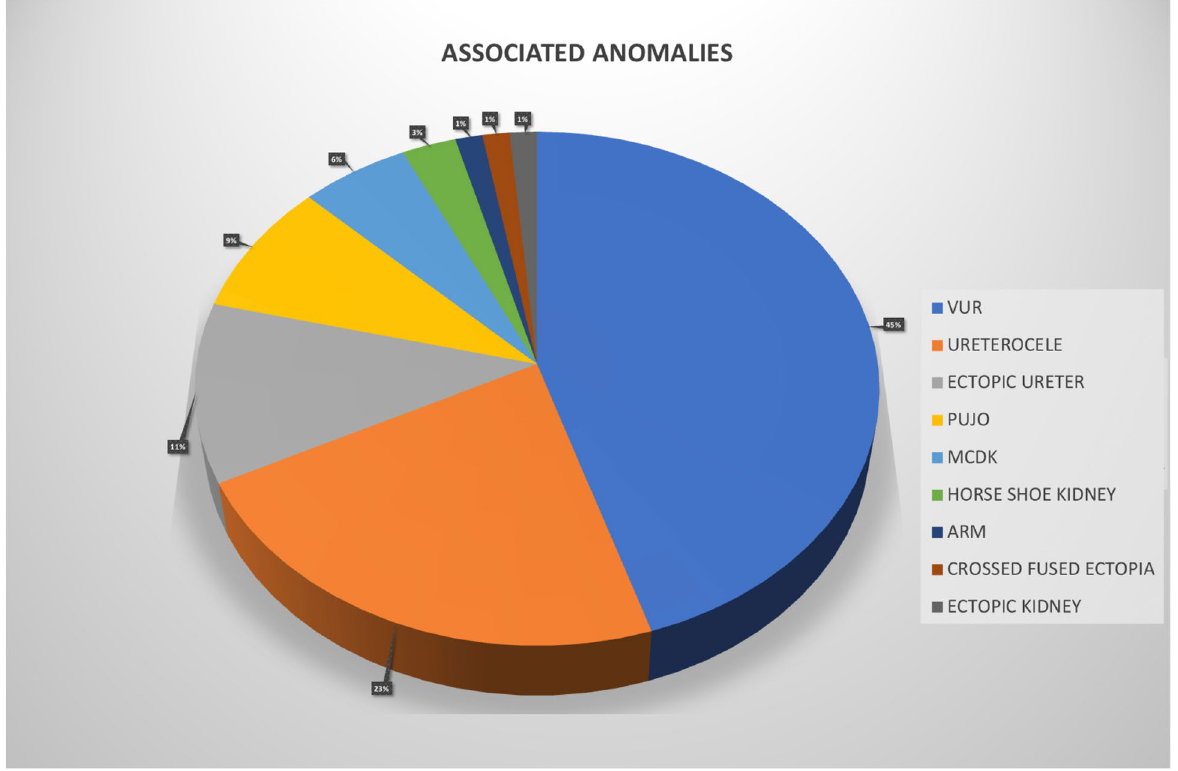
Fig. 7 Pie diagram depicting the associated anomalies of duplex in our